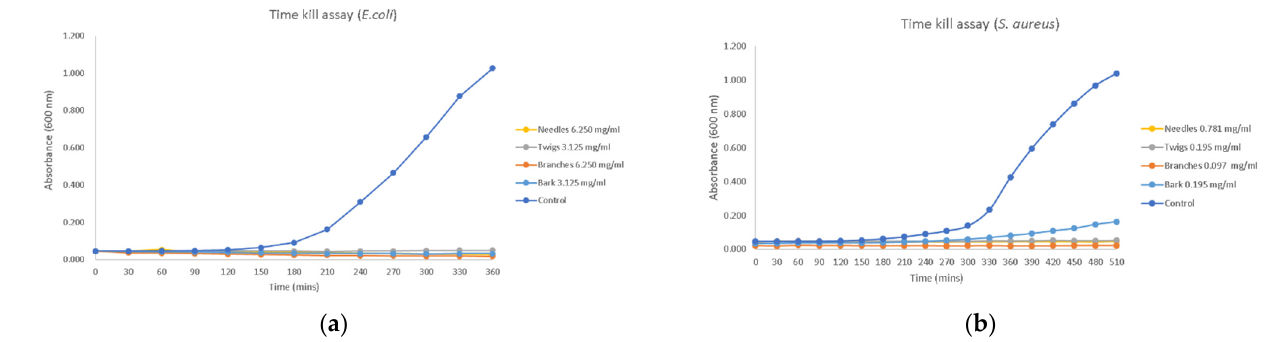
Figure 1. Time–kill assay for C. brevifolia : ( a ) Growth curves of E. coli with methanol extracts of needles, twigs, branches, and bark; ( b ) Growth curves of S. aureus with methanol extracts of needles, twigs, branches, and bark.